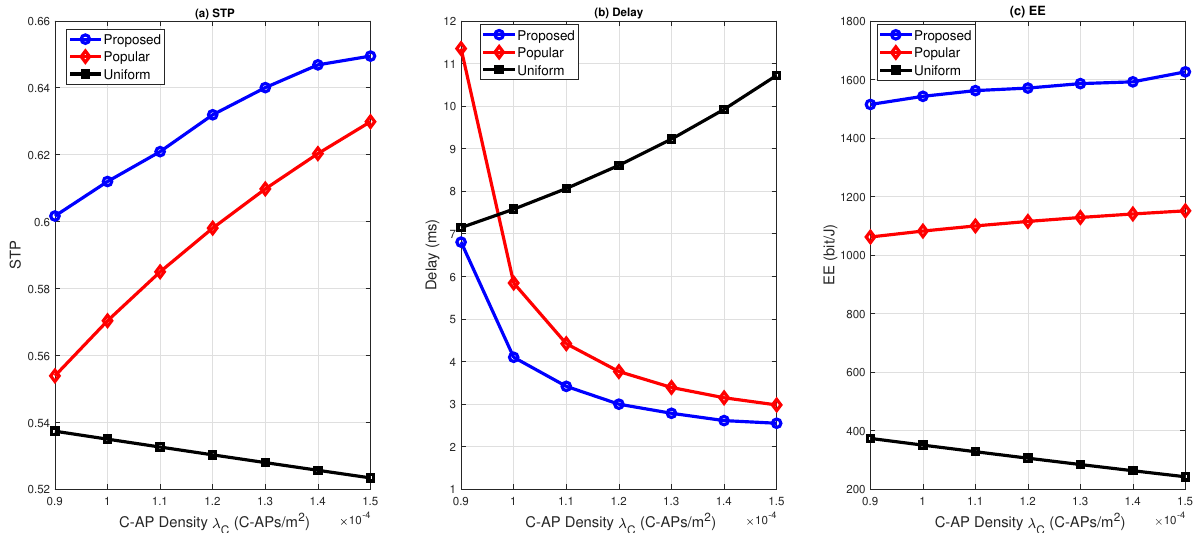
Figure 9. STP, delay, and EE versus C-AP density when M = 20 contents, λ U = 0.1 users/m 2 , λ F = 0.01 F-APs/m 2 , R = 150 m, γ = 0.8, α = 4, P F = 30 dBm, P C = 40 dBm, P s = 37 dBm, ρ = 15.13, W F = 100 MHz, W C = 500 MHz, T = 1 ms, and τ = 0.1 Mbps.